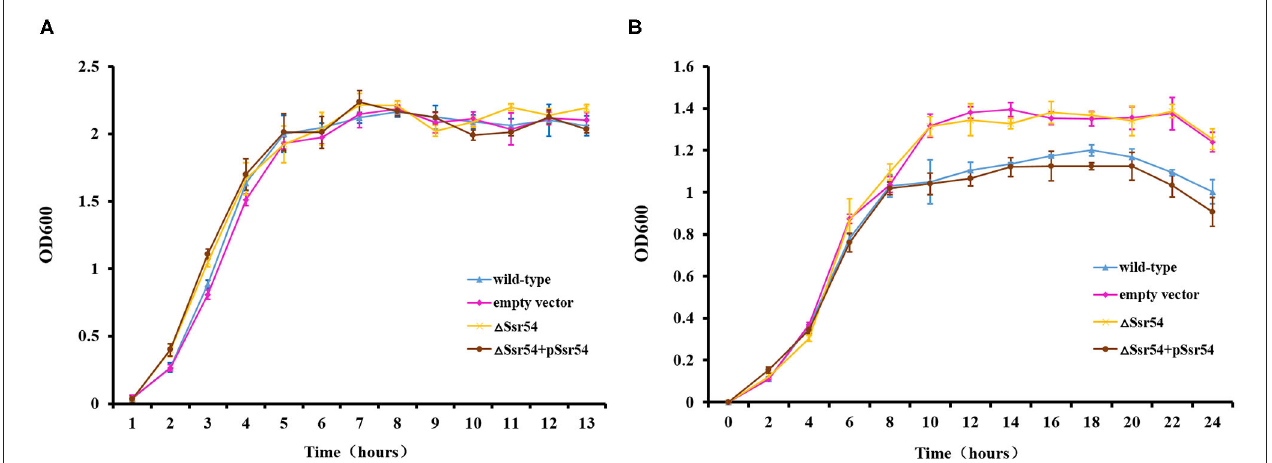
FIGURE 3 | Osmotic stress of the Ssr54 mutant. Growth characteristics of the wild-type, Ssr54 mutant, and complement strains, as well as the mutant strain carrying the pACYC184 empty vector, in LB under different osmotic conditions: (A) 0mM NaCl; (B) 680mM NaCl. The error bars indicate standard deviations based on triplicate experiments. Statistical analyses were performed using Student’s t -test.